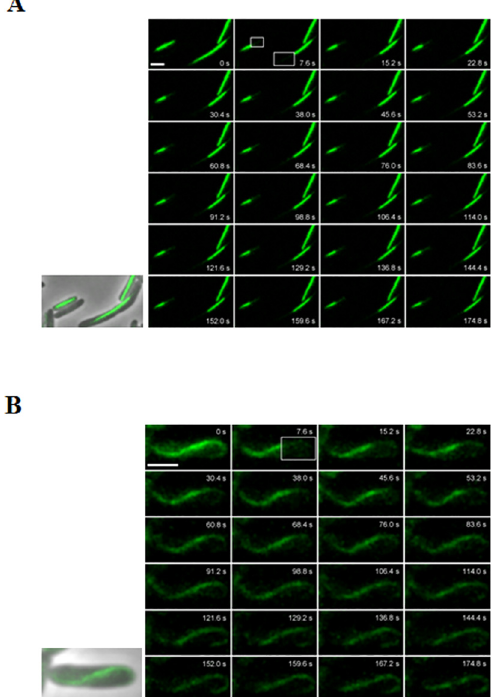
Fig 4. ParM-YFP filaments are dynamic in the presence of parC and ParR. E . coli cells expressing either ParM-YFP in isolation (A) or ParM-YFP in the presence of parC and ParR were grown to mid-logarithmic phase and selective photobleaching experiments were undertaken. Fluorescence recovery was monitored by imaging cells every 7.6 seconds over the course of three minutes. The first image in the series depicts a pre- bleached cell. Phase contrast/fluorescence overlay images of cells expressing ParM-YFP are shown to the left of the photobleaching montage. Boxes indicate regions of laser photobleaching. Time units (seconds; s) are shown. Scale bars represent 2 μ